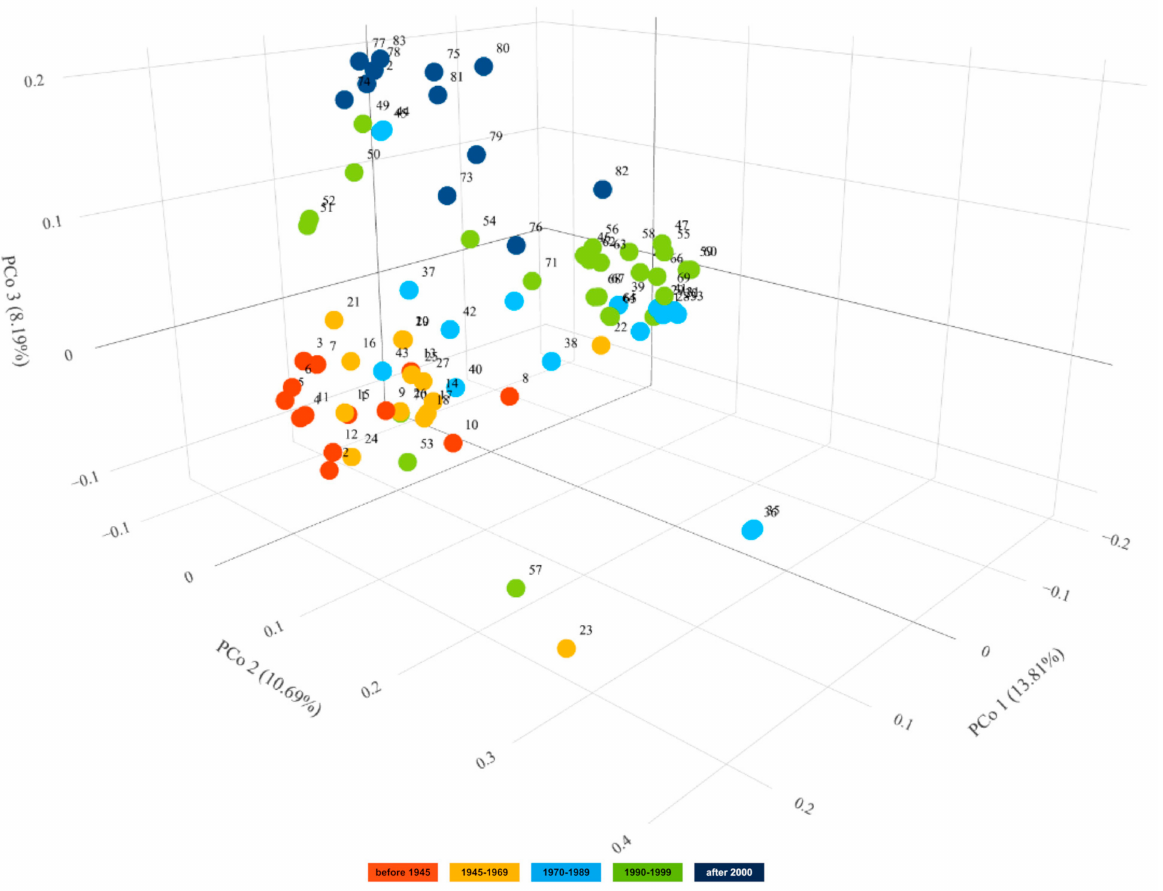
Figure 8. Graphical presentation of the Principal Coordinate Analysis results for DArTseq data of 83 spring barley cultivars. Results in the first three coordinates’ system. Each point denotes one tested cultivar. Numbering according to Table 6. Rotable 3D figure can be found in the supplementary materials (Figure